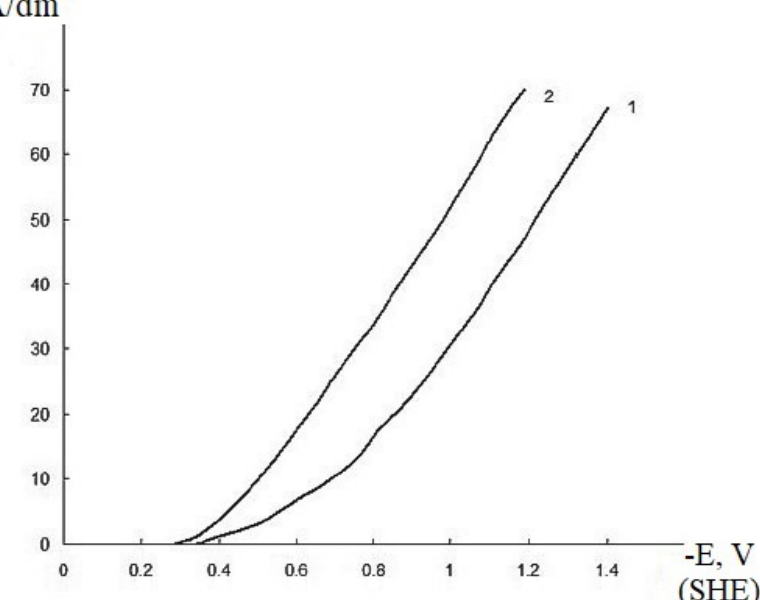
Figure 1. Potentiodynamic polarization curves of deposition of nickel–chromium alloy: 1—without additive; 2—together with graphene oxide (potential sweep rate Vs = 8